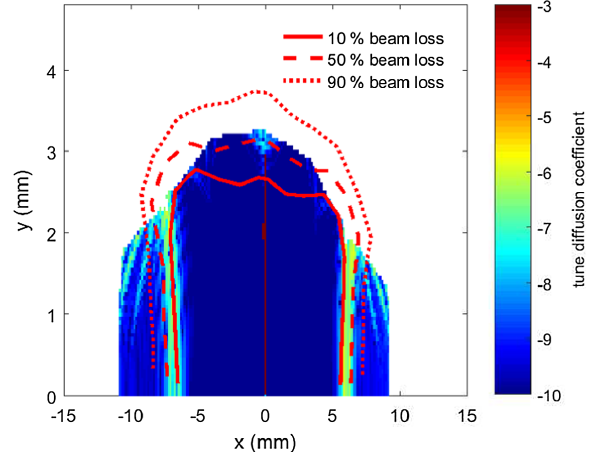
FIG. 4. Measured dynamic aperture following the installation of the DDBA cell (red lines). For comparison, the dynamic aperture computed using the machine model is also shown.